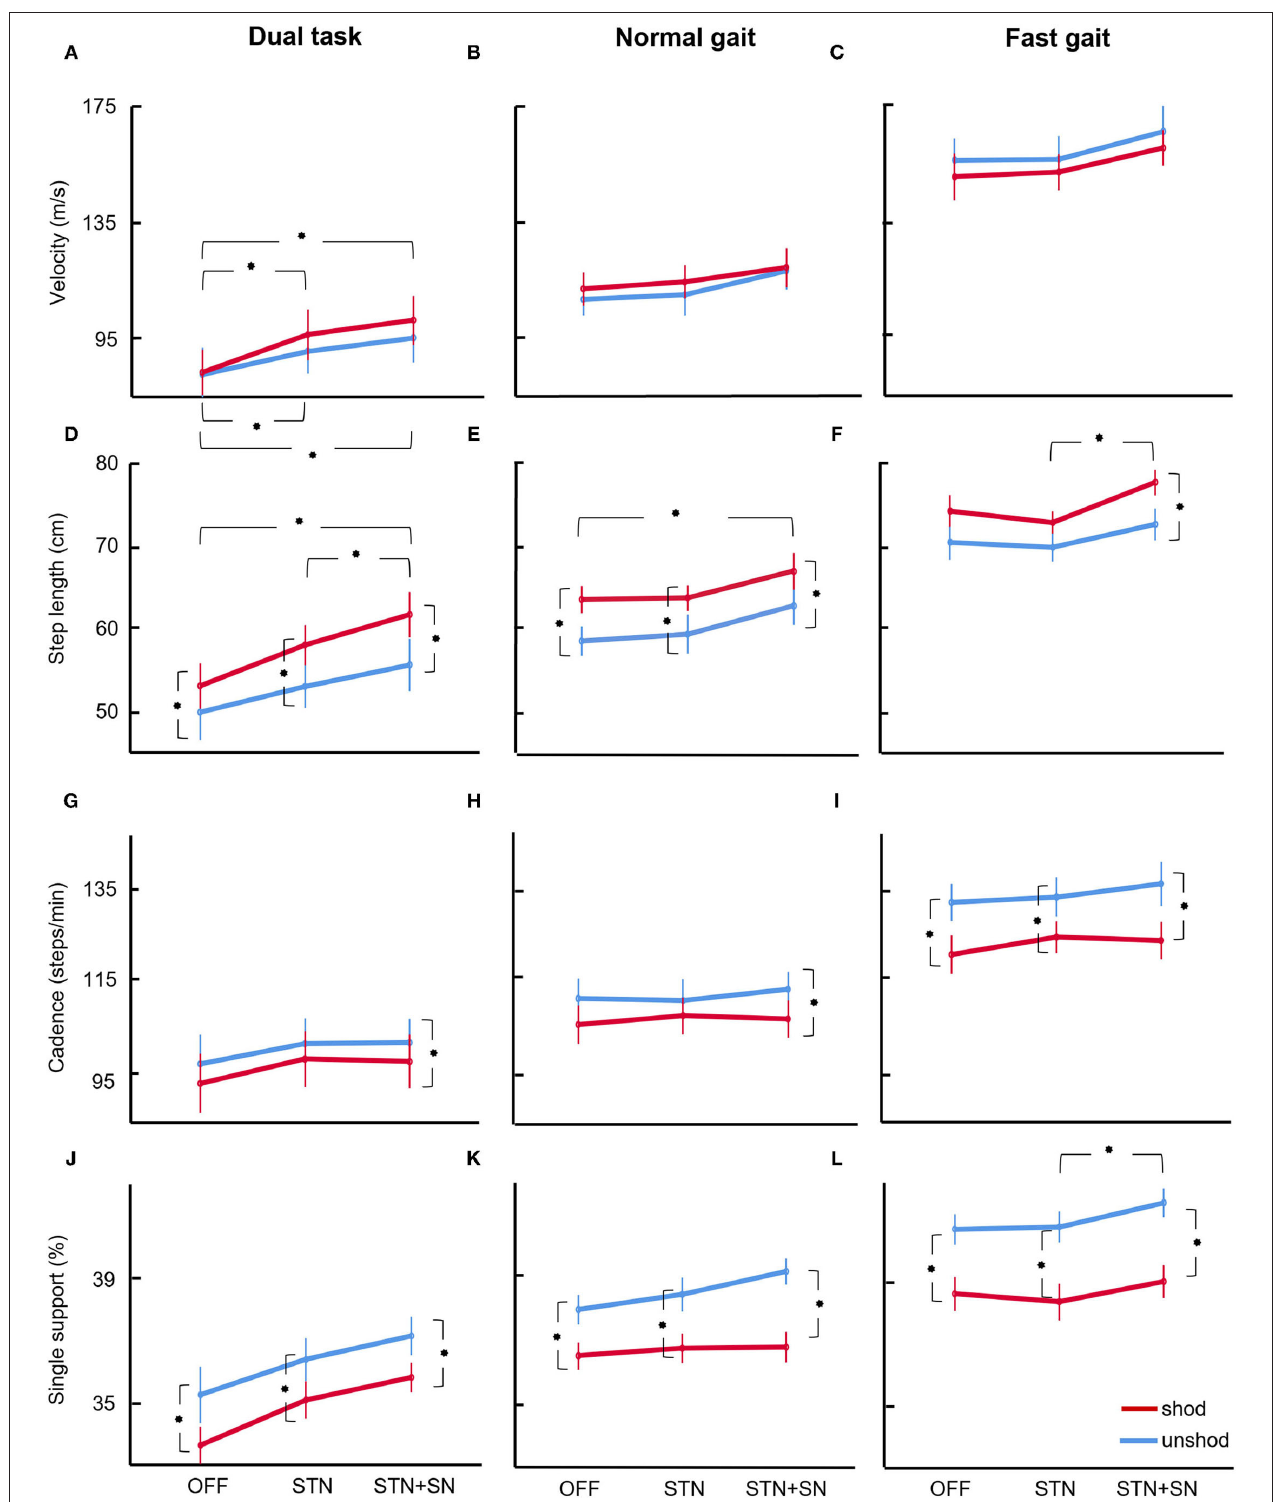
FIGURE 2 | ANOVA results. Results for ANOVA on gait parameters velocity (panels A–C ), step length (panels D–F ), cadence (panels G–I ), and single support (panels J–L ) are shown for patients with PD OFF DBS, and under STN or STN + SN DBS for the paradigms normal gait, fast gait, and dual task. Line plots are ranked by task pace, i.e., from the slowest pace during the dual task (left) to the fastest pace during the fast gait task (right) . Values reported are mean and SE bars. Stars denote significant post hoc Wilcoxon signed-ranks tests between gait parameters in the unshod and shod conditions and in the three stimulation conditions ( p < 0.05).